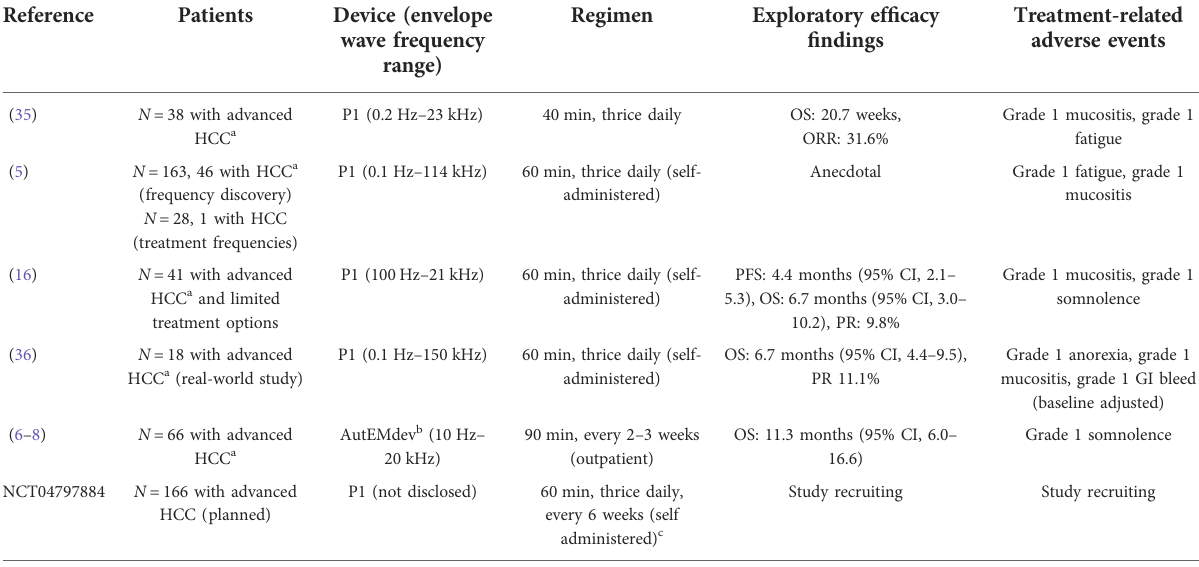
TABLE 2 Clinical studies of low-power AM RF EMF devices using a 27.12 MHz carrier wave in patients with HCC.